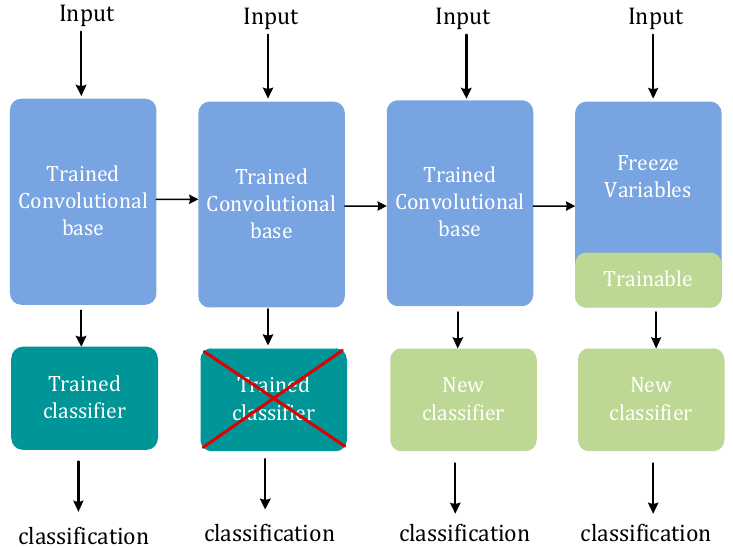
Figure 9. Fine-tuned ResNet. Firstly, the classifier of the pre-trained network was substituted by a feature classifier, which was adapted to this training data. Secondly, the model weights in the low-level convolution part were frozen. It was justified because the previous part of the convolution was used for feature extraction, and the deeper convolutional layer with a more abstract concept was trained along with the feature classifier. Finally, we fine-tuned a high-level convolution part according to training data.